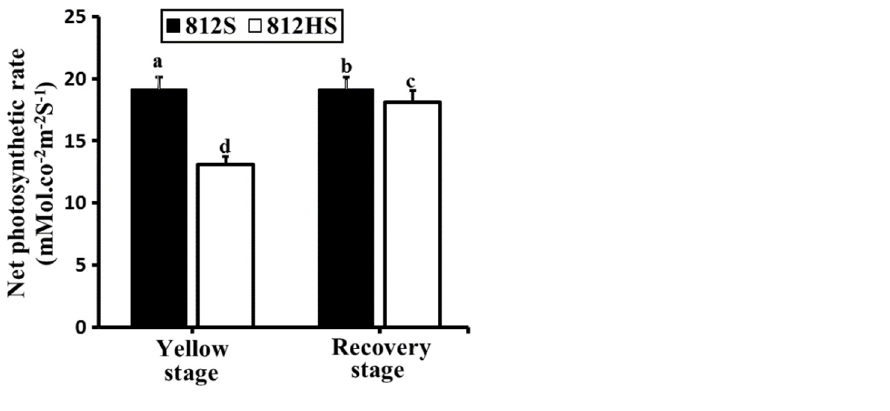
Figure 3. Effects of photooxidation on the net photosynthetic rate in leaves of 812HS and 812S. Different letters indicate significant variation ( p < 0.05).